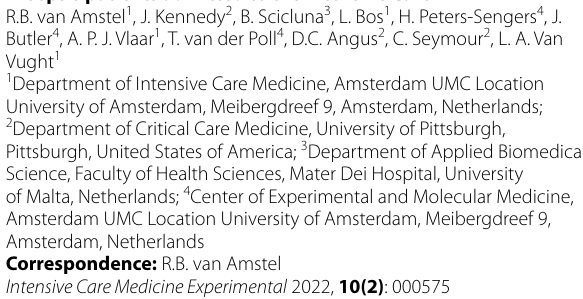
0,370), = 0,567) in septic adult =